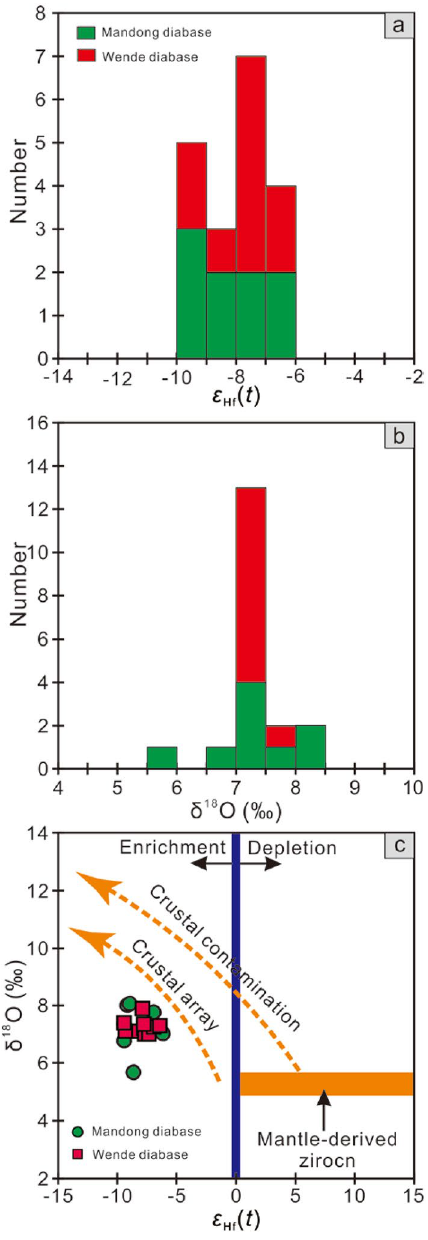
Figure 6. Histogram of Hf–O isotopic data ( a , b ) and ε Hf ( t ) versus δ 18 O correlation diagram ( c ) of zircon crystals from the studied mafic rocks in the Baotan